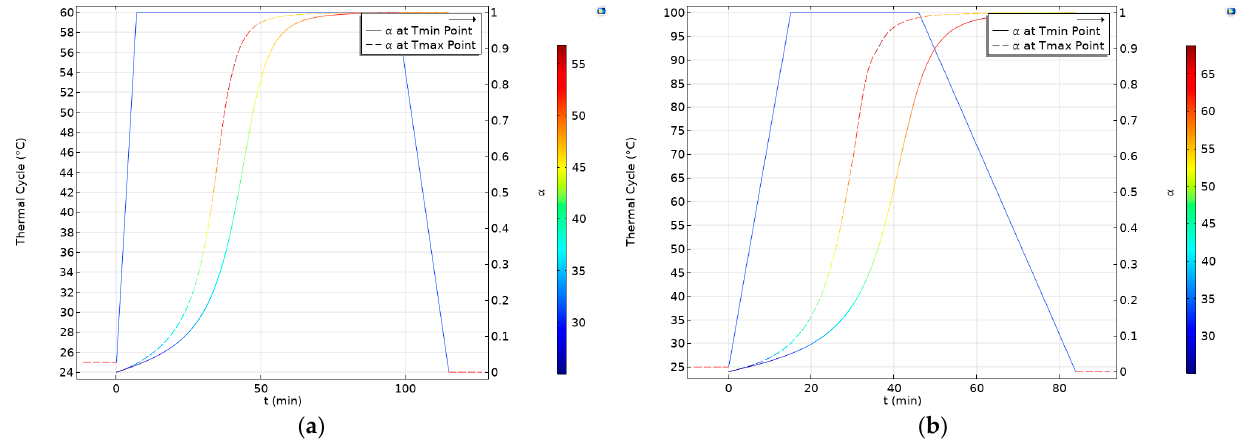
Figure 8. Thermal cycle vs. α (DoP) for the curing cycle at ( a ) 60 °C and ( b ) 100 °C.